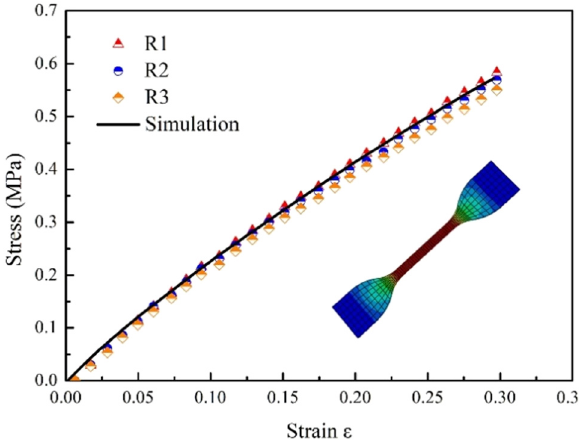
Figure 6: Stress – strain curve of experiments and FEA results.